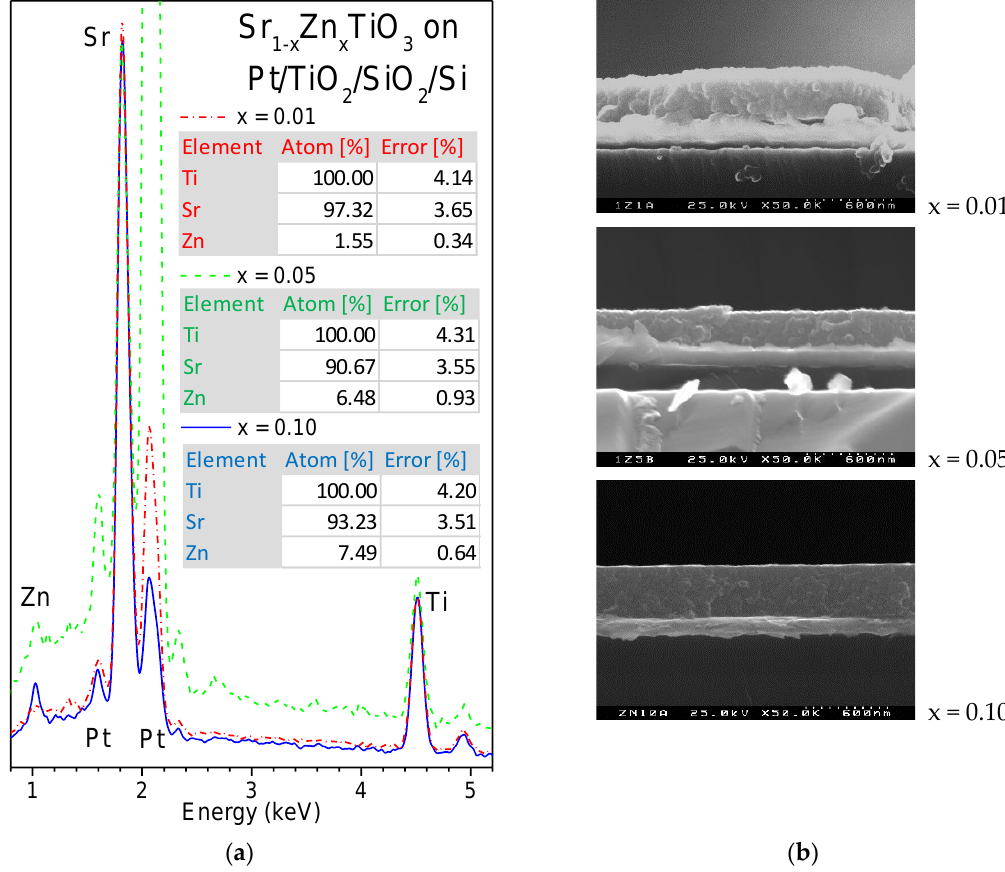
Figure 2. Energy-dispersive spectra ( a ) and SEM cross-section micrographs ( b ) for Sr 1-x Zn x TiO 3 thin films with x = 0.01, 0.05, and 0.10 deposited on Pt/TiO 2 /SiO 2 /Si substrates. The spectra quantification results are also presented in ( a ). Table 1. Average thickness, grain size, root mean square (RMS) roughness, peak dielectric permittivity value, peak dissipation factor value, and temperature at 10 kHz for Sr 1-x Zn x TiO 3 thin films deposited on platinized Si substrates.